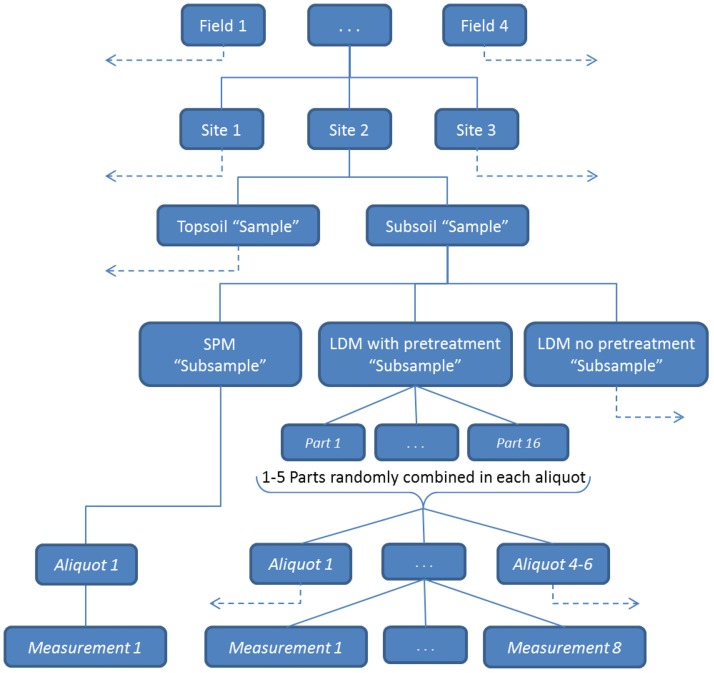
Hierarchical data structure defining the study design.Dashed arrows represent duplicates of the same sampling structure shown. Levels in italic text are not independent replicates. Sieve plummet balance method, SPM; Laser diffraction method, LDM.